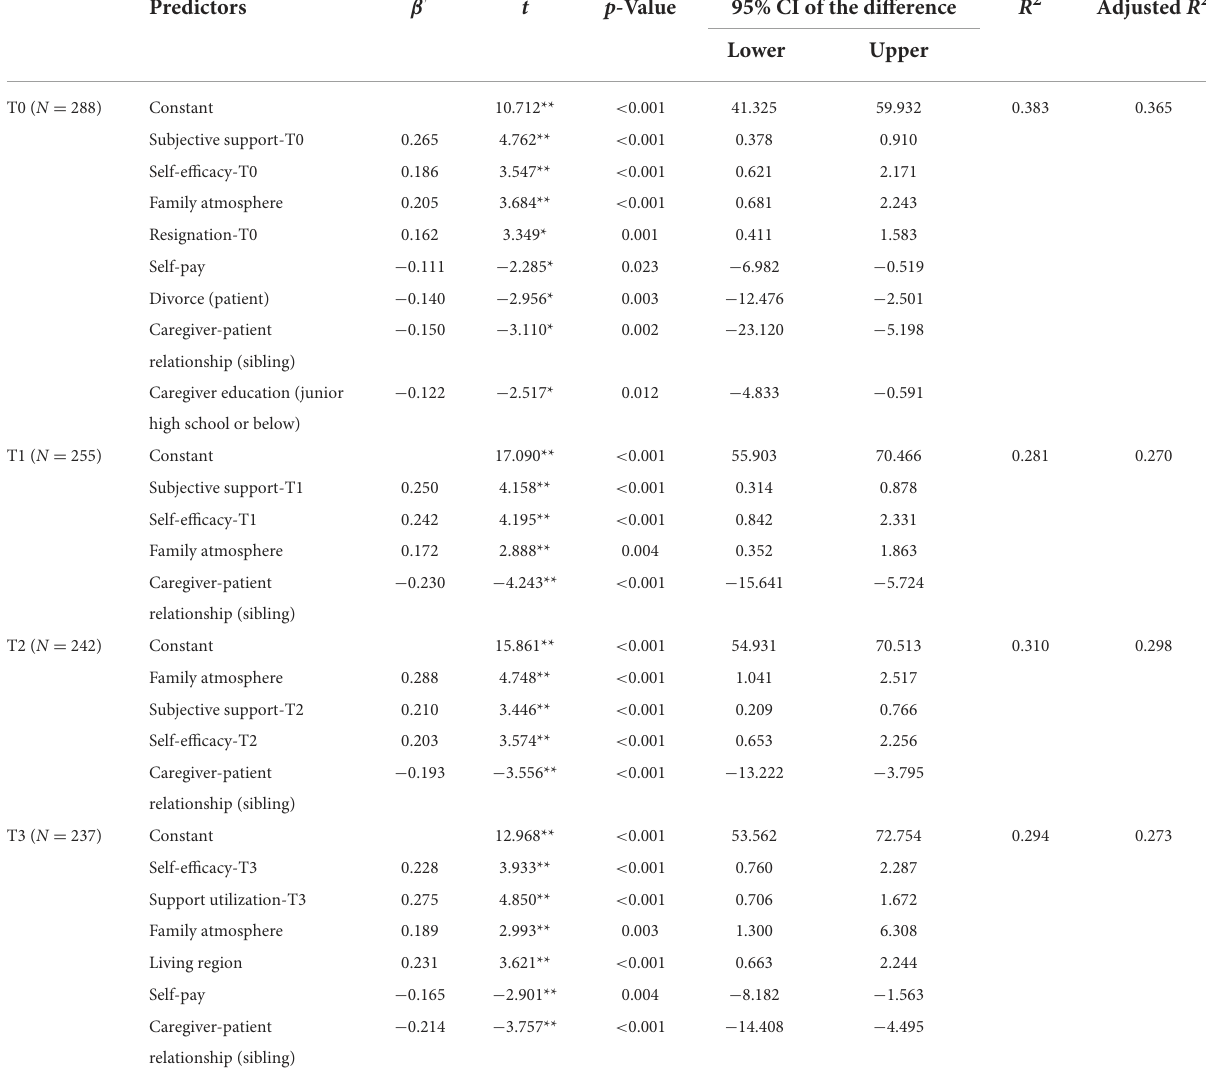
TABLE 4 Multiple linear regressions for predictors of family resilience at four time